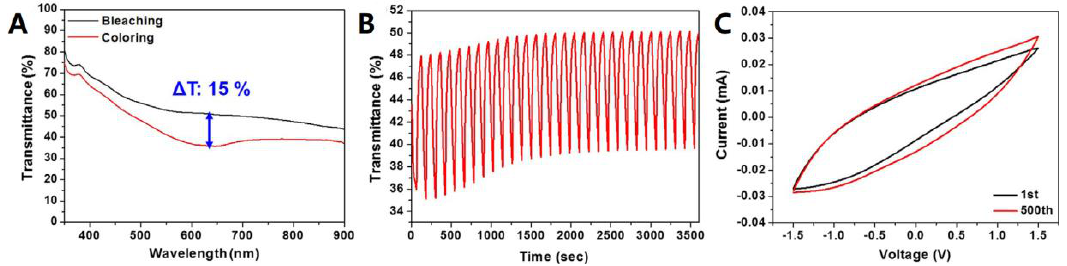
Figure 19. Characterization of poly(3,4-ethylenedioxythiophene) (PEDOT):poly(styrene sulfonate)